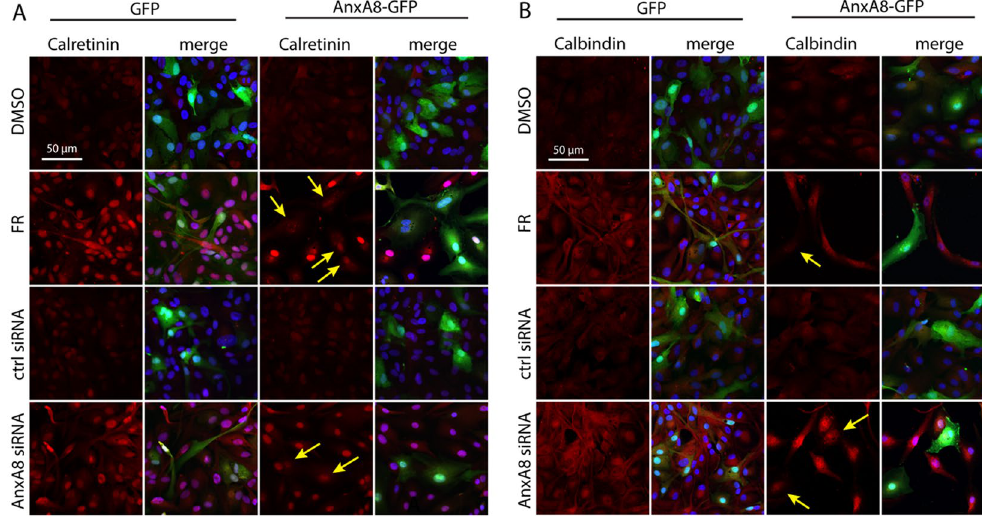
Figure 5. Suppression of AnxA8 is required for induction of calretinin and calbindin. ( A ) Cells were transfected with either GFP or AnxA8-GFP and then treated with FR or AnxA8 siRNA (with appropriate controls) for 3 days. Images show elevated staining for calretinin (red) upon exposure to FR and AnxA8 siRNA, with the merged images showing GFP (green) and nuclei (DAPI, blue). In cells transfected with AnxA8-GFP we observed many instances where there was no apparent increase in expression of calretinin (yellow arrows) following FR or AnxA8 siRNA when compared to DMSO control and control siRNA treatments. Presented are representative images from three independent experiments, scale bar = 50 μ m. Similar analysis of calbindin ( B ) in the same set of experimental conditions revealed patterns of expression almost identical to those described above for